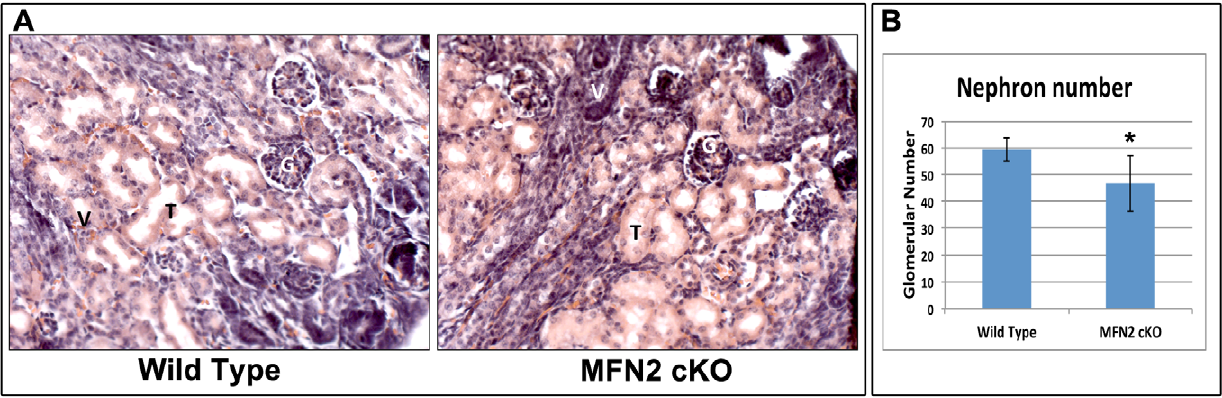
Figure 2. Effect of MFN2 conditional knockout on renal histology. ( A ) Wild type and MFN2 cKO kidney sections stained with hematoxylin and eosin; Tubules ( T ), glomeruli ( G ) or vasculature ( V ) appeared similar in both tissue sections. ( B ) Morphometric analysis of glomerular number in kidneys of wild type and MFN2 cKO littermates (n=5/group). Data represent the mean and SD; * P , 0.05.